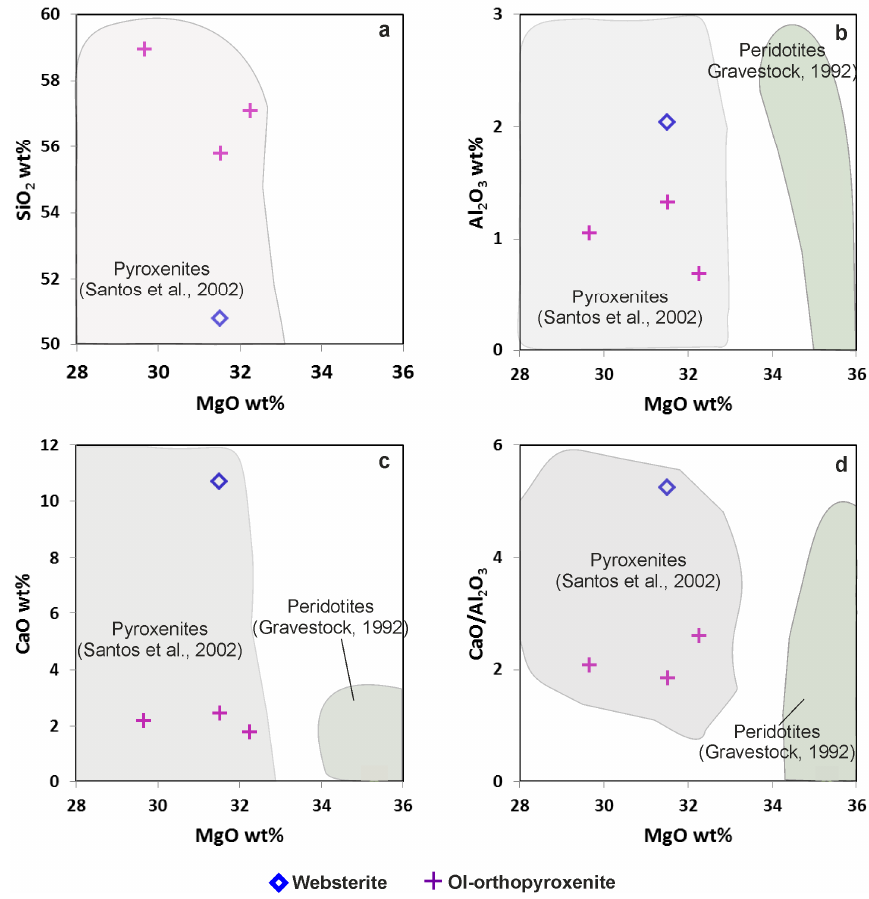
Figure 5. Variations of MgO versus: SiO 2 ( a ); Al 2 O 3 ( b ); CaO ( c ); and CaO/Al 2 O 3 ( d ), for the pyroxenites from the Veria-Naousa ophiolite (recalculated values to 100% on an anhydrous basis). Fields include data from Gravestock [44] and Santos et al. [45] for the Cabo Ortegal pyroxenites and peridotites.